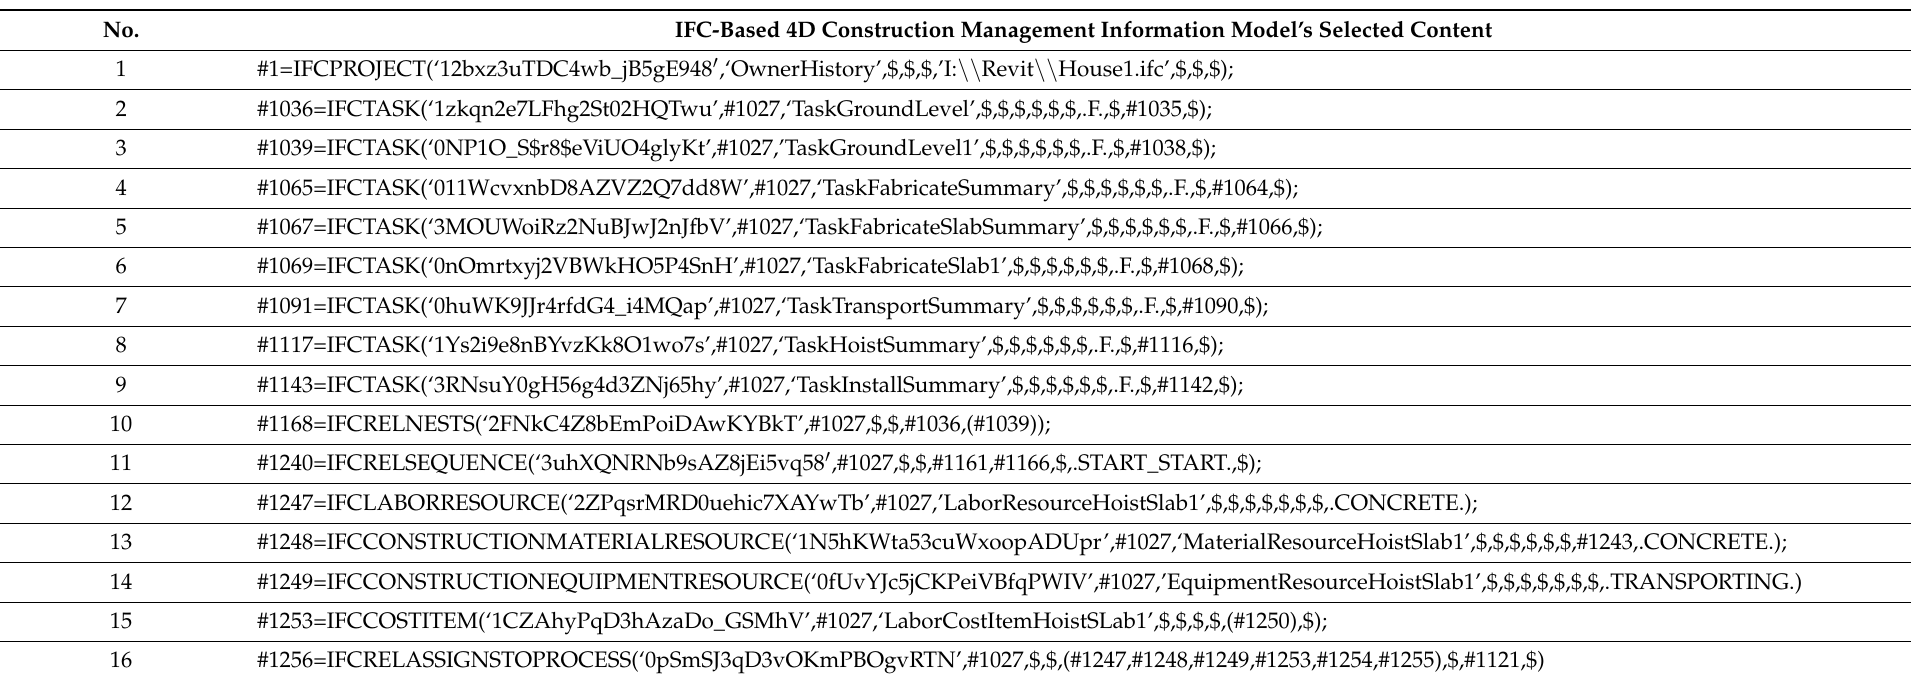
Table 7. IFC file of IFC-based 4D construction management information model. (The single quotes in this table are necessary to observe the IFC standard’s regulation.). No. IFC-Based 4D Construction Management Information Model’s Selected